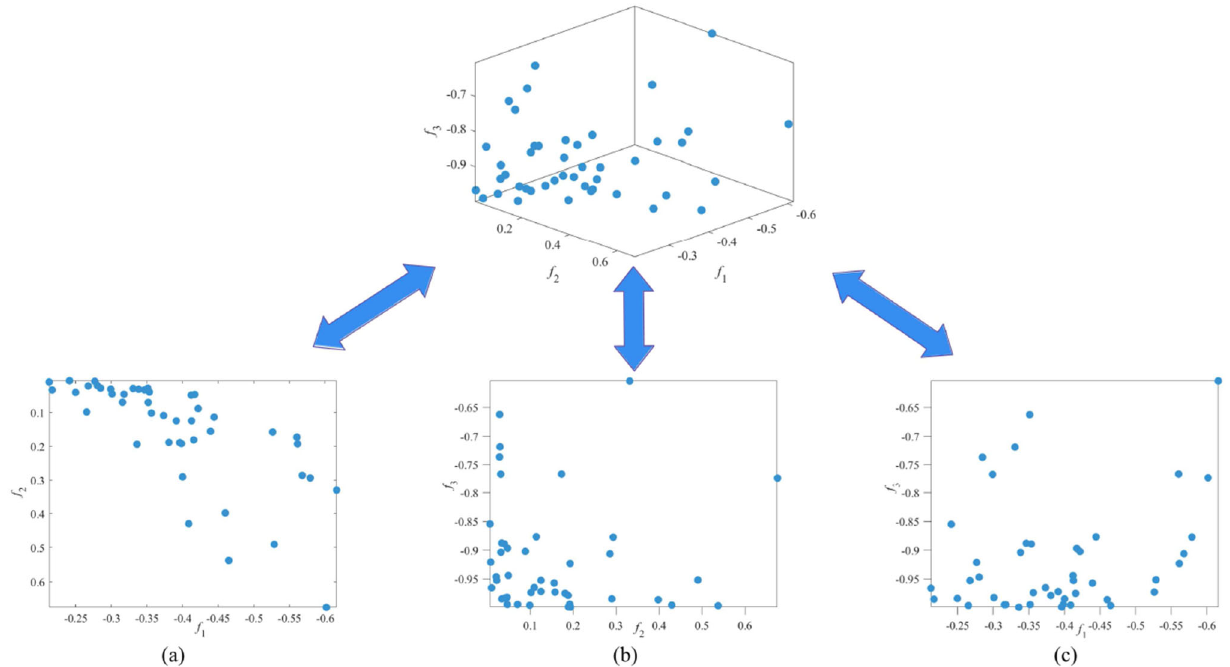
Fig. 8 The Pareto front of the proposed dynamic model with three objectives. a Comparison diagram of the average propulsive speed and the head stability. b Comparison diagram of the head stability